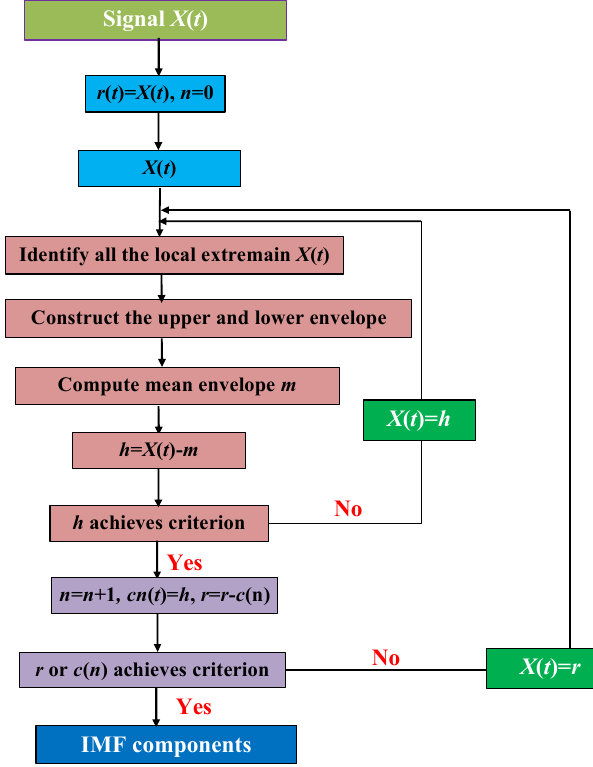
Figure 4. Flowchart for EMD approach [43].